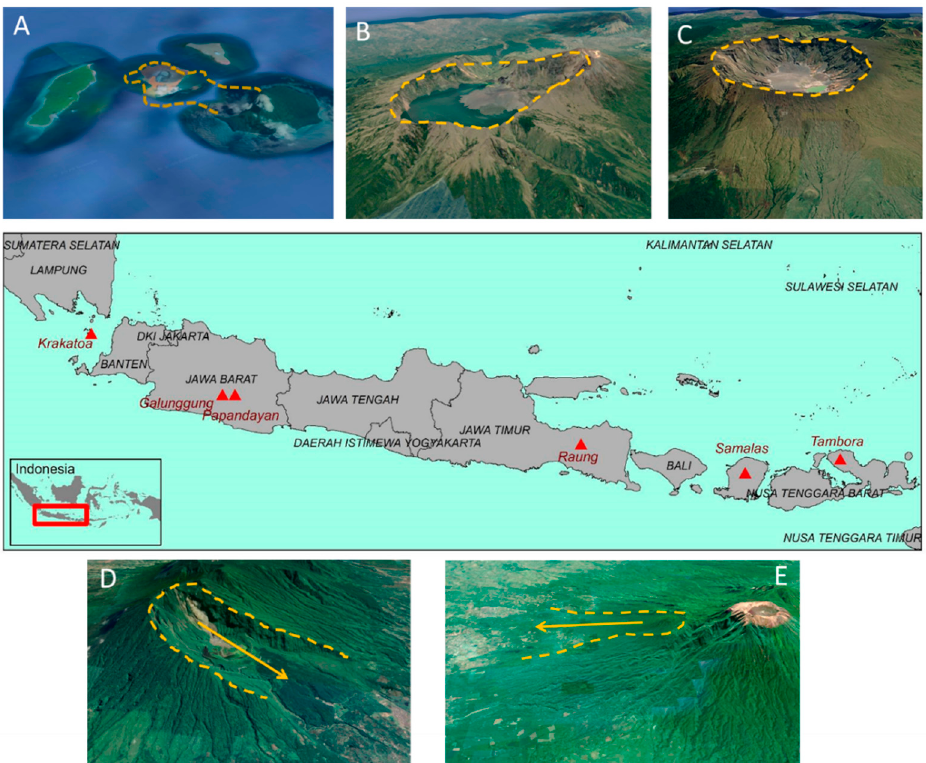
Figure 3. Massive caldera-forming eruptions during modern historic time in Indonesia: ( A ) Krakatoa, ( B ) Samalas, and ( C ) Tambora. The morphological remnant of horse-shoe edifice resulted from sector collapse of ( D ) Galunggung and ( E ) Gunung Gadung, Raung volcano, visible from Google Earth imagery.